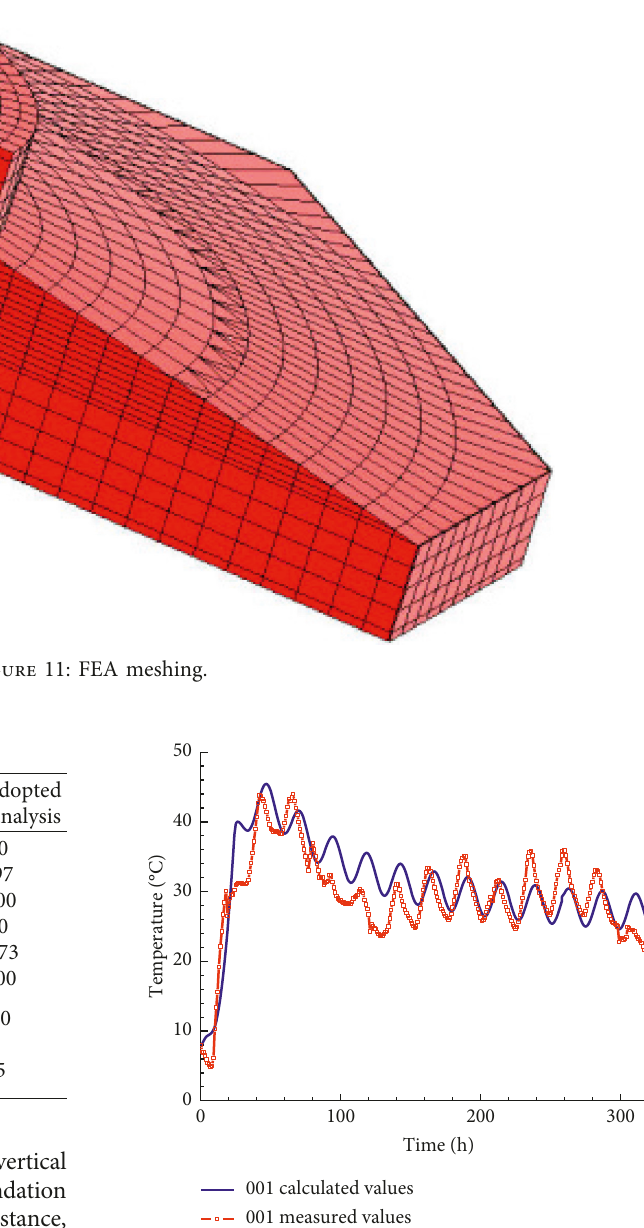
Figure 12: Comparison between the calculated and measured values for Point 001.